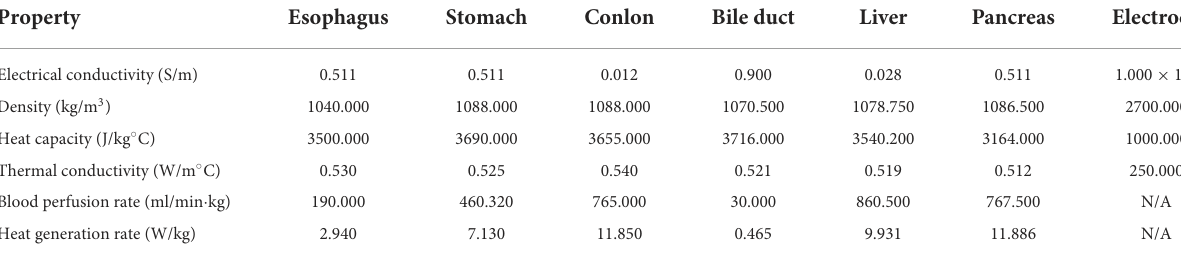
TABLE 2 The electrical and thermal properties of